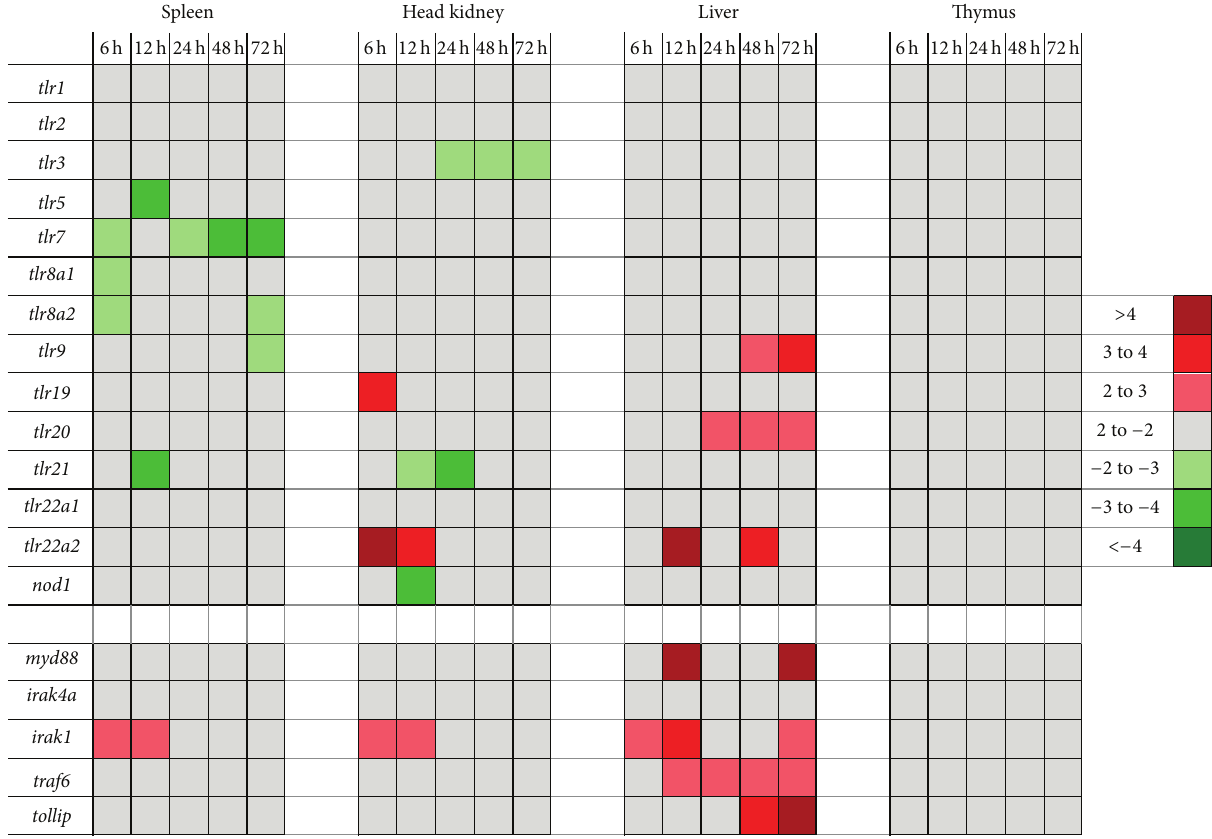
Figure 4: Modulation of the mRNA concentration of factors contributing to TLR signaling during infection. Colored fields represent significantly ( 𝑝 < 0.05 ) altered fold changes ( > 2-fold) of the mRNA concentrations as measured in the respective organs at the various times after infection. The pertinent data are listed in Tables 3(a) and 3(b).